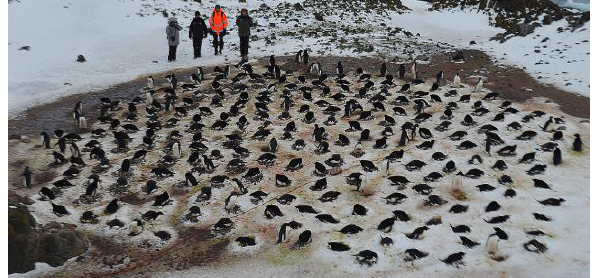
Figure 4. Ground censuses of penguin nests according to CEMP standard methods.